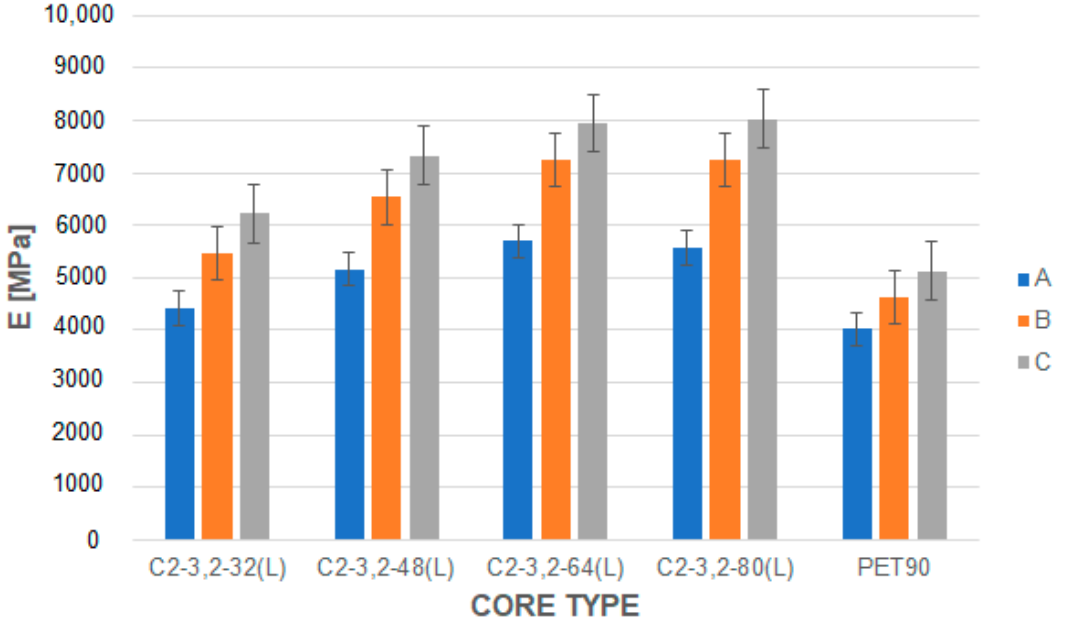
Figure 7. Influence of coating types (A–C) on the effective bending modulus of sandwich constructions; core used: C2 type honeycomb with unified mesh size 3.2 mm and different densities (32, 48, 64, and 80) kg·m − 3 , L orientation, and PET foam (90 kg·m − 3 ).